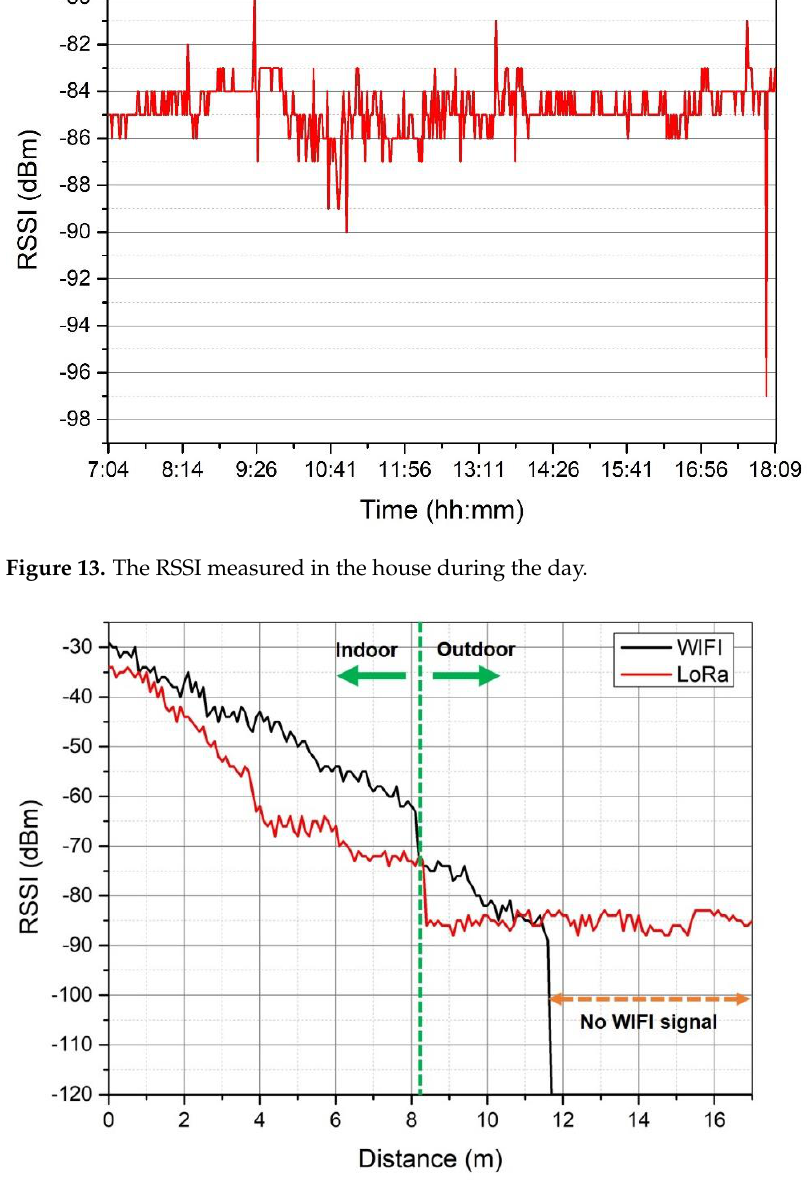
Figure 14. The LoRa RSSI compared to WIFI, according to indoor and outdoor distances.